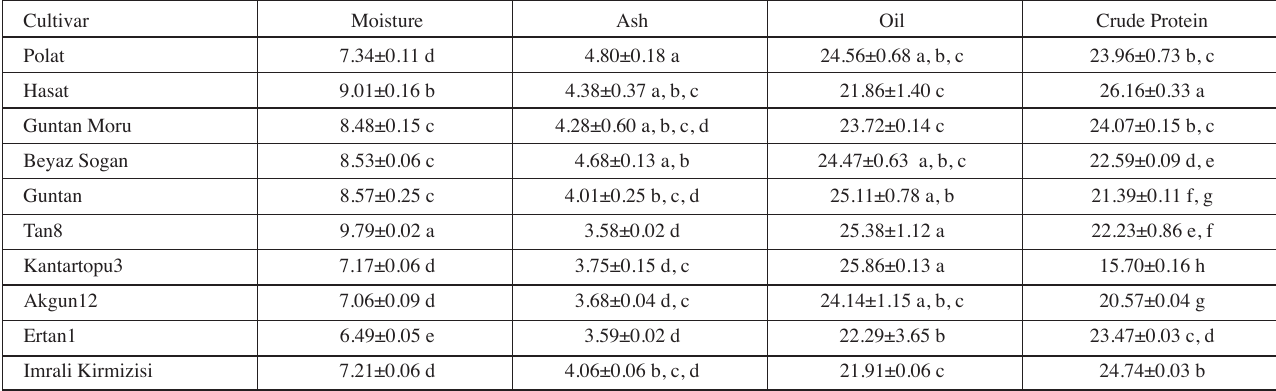
Tab. 1: Chemical composition of different onion seed cultivars (%)